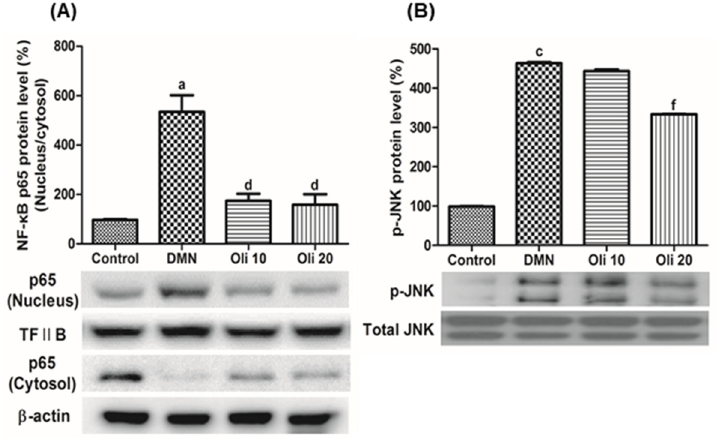
Figure 6. Effects of oligonol on DMN-induced NF- κ B p65 activation ( A ) and JNK phosphorylation ( B ). Western blotting was performed to detect the relative level of NF- κ B p65 in the nuclear and